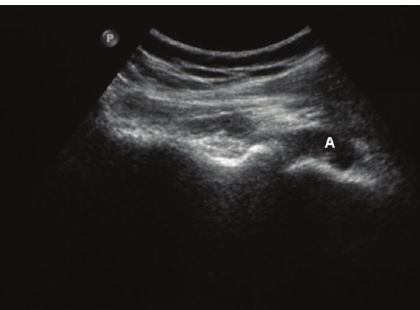
Figure 1: Ultrasound of the right shoulder joint using an axial posterior approach to the glenohumeral articulation showing a markedly distended posterior aspect of joint capsule by fluid